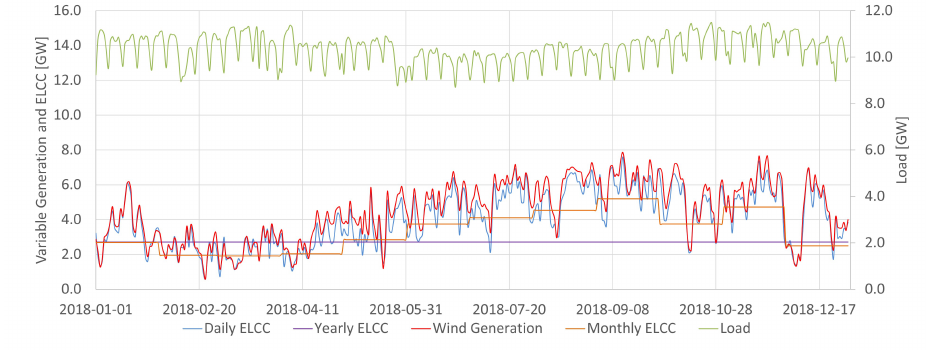
Figure 12. Daily, monthly and yearly ELCC for wind power in 2017 for the Northeast subsystem.